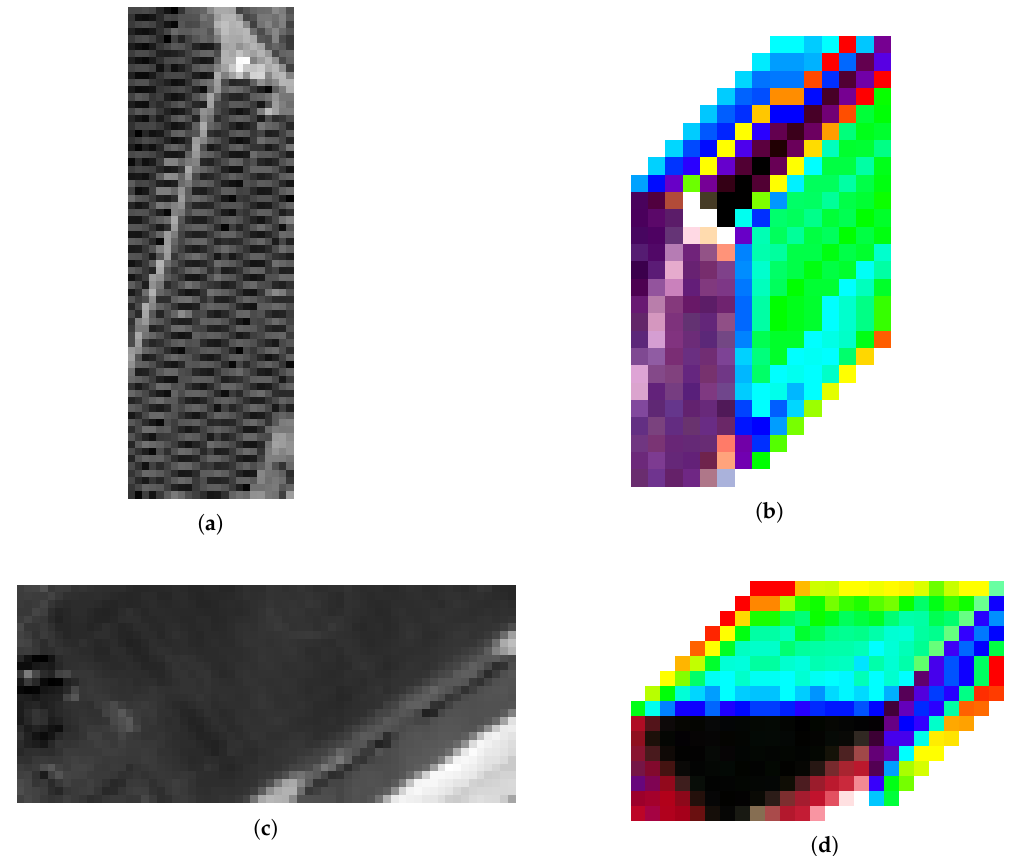
Figure 9. HYPXIM/HYPEX2 simulated data sets: ( a ) Mauzac 2.2 m GSD TOA PAN image, ( b ) Mauzac 8.8 m GSD ground reflectance HS image, ( c ) Basel 2 m GSD TOA PAN image and ( d ) Basel 8 m